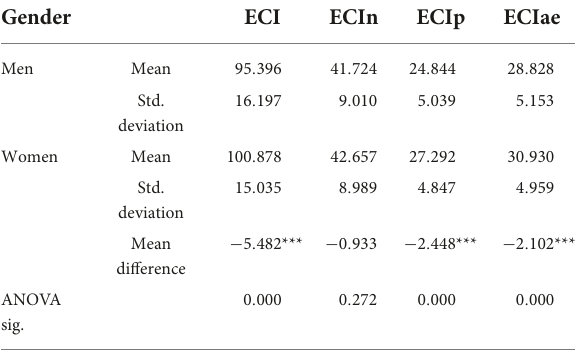
TABLE 2 Gender differences in emotional creativity.